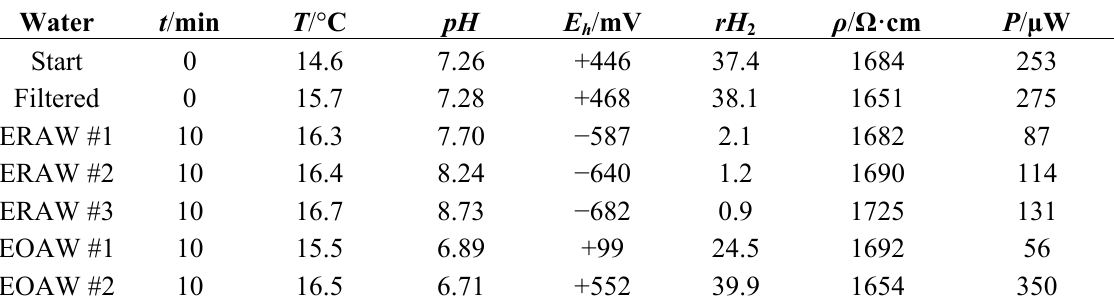
Table 2. Physicochemical properties of three types of reduced alkaline electrolyzed water (ERAW) and two types of oxidized acidic electrolyzed water (EOAW). t : duration of electrolysis; E : redox potential; r : electrical resistance; P : electrochemical power. h